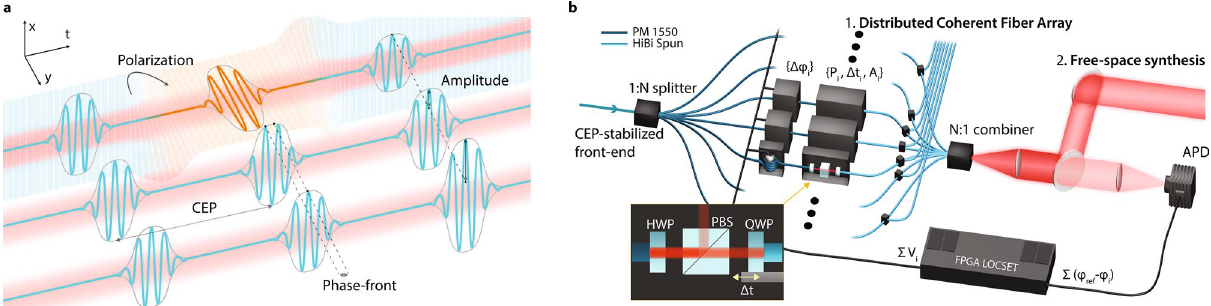
Figure 1. ( a ) conceptual depiction of a transversely and longitudinally coherent optical comb and the corresponding primary elements that define how the electromagnetic field distribution will synthesize; and ( b ) the experimental configuration via coherent multi-channel coherent fiber array with a common CEP-stabilized front end, independent phase ( �φ i ), amplitude ( A i ), polarization state ( ℘ i ), and timing ( (cid:31) t i ) controls, and active locking via FPGA LOCSET using a single avalanche photodiode (APD) in the far-field. The output coherent output can be delivered in the form of a distributed coherent fiber array or the form of a free-space synthesized